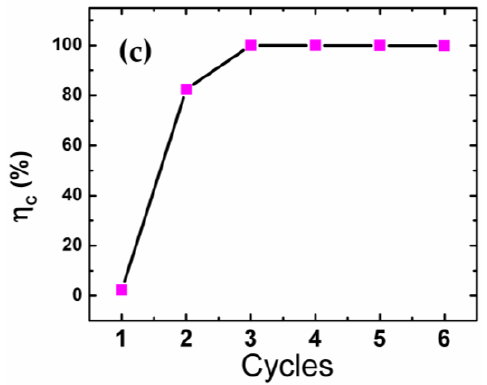
Figure 5. ( a ) Calculated diffusion coefficients and ( b ) Diffusion lengths for 1–6 SILAR cycles. ( c ) Charge collection efficiencies calculated for 1–6 SILAR cycles.